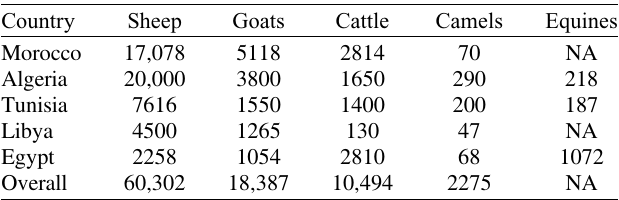
Table 4. Estimated domestic herbivore population in North Africa (1000